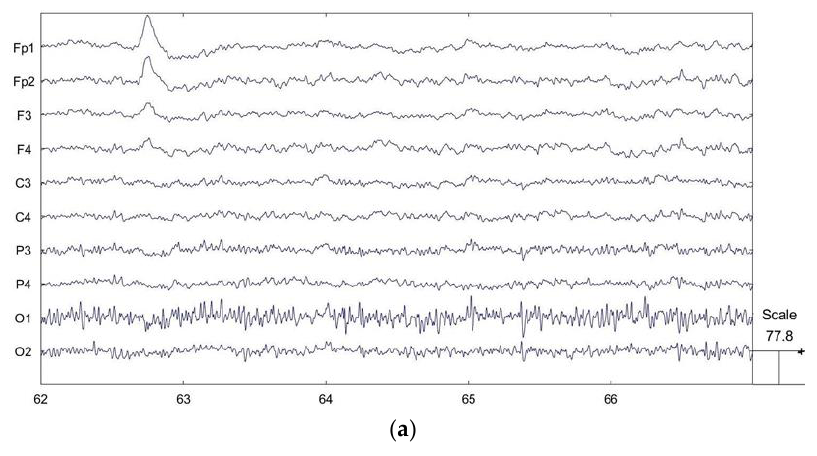
Figure 3. EEG topography of different signal components and attributes of electrooculogram artifacts. The energy distribution of the component containing electrooculogram artifacts (IC1) is concentrated in the forehead and can be identified and removed based on this characteristic.